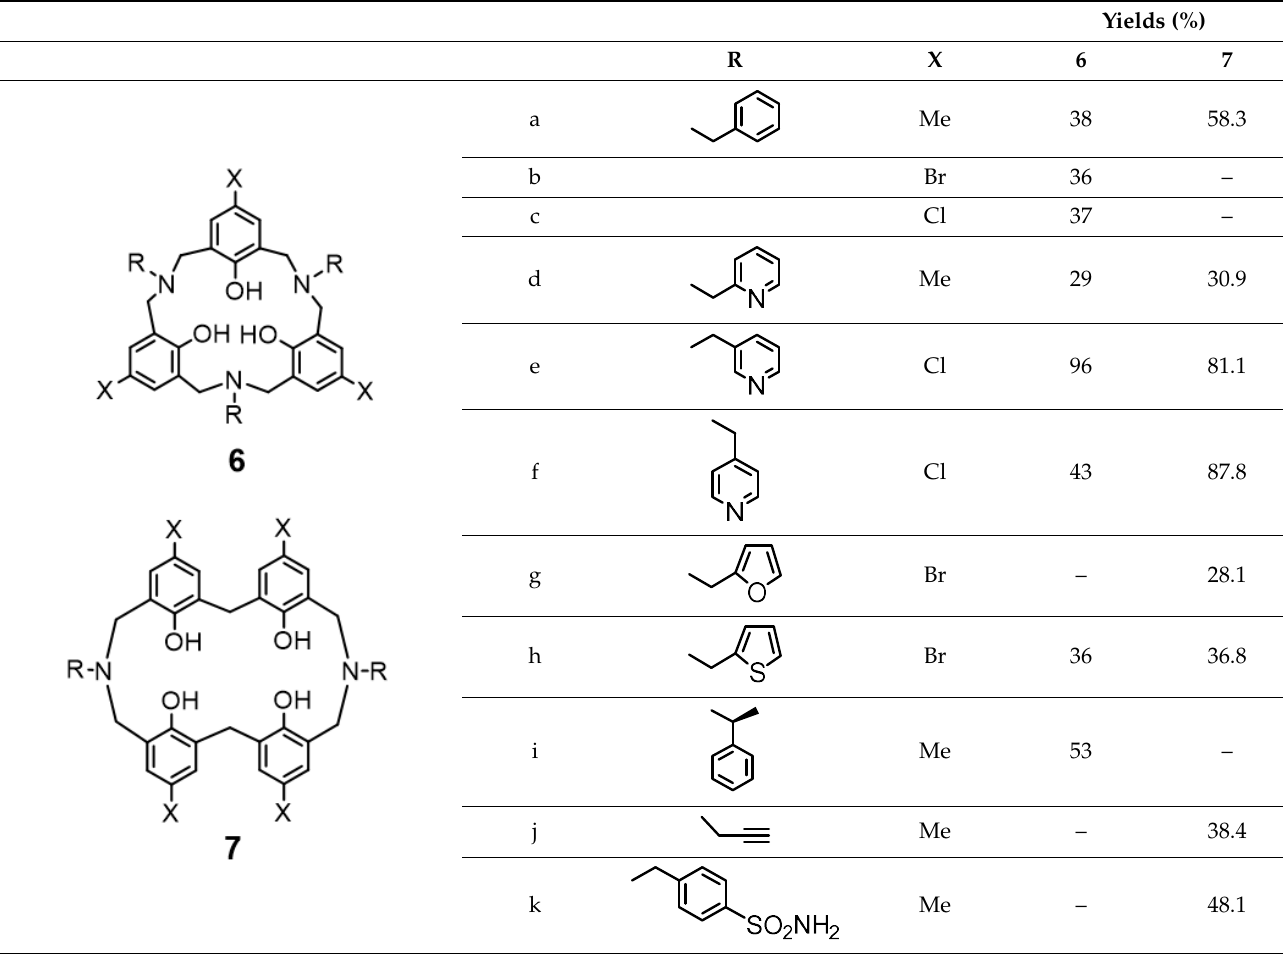
Table 1. Yields of azacalixarenes with various side chains.